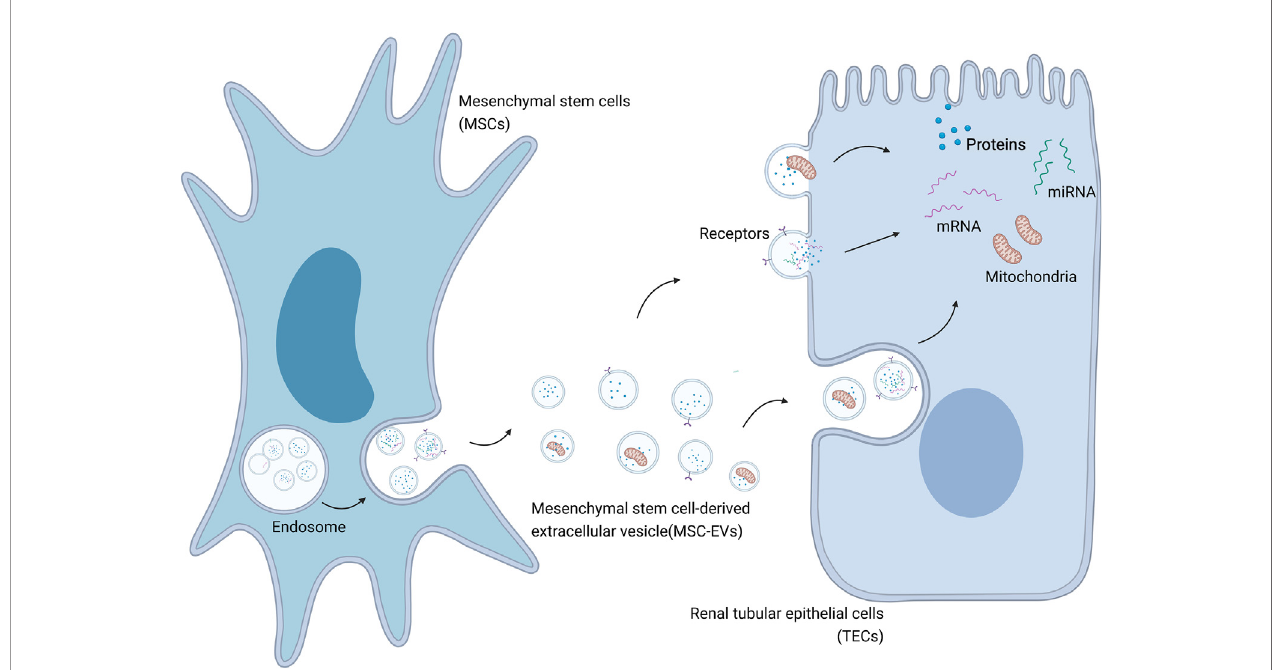
FIGURE 1 | MSC-EVs mediate transportation of biological modules to injured cells in AKI. Created with